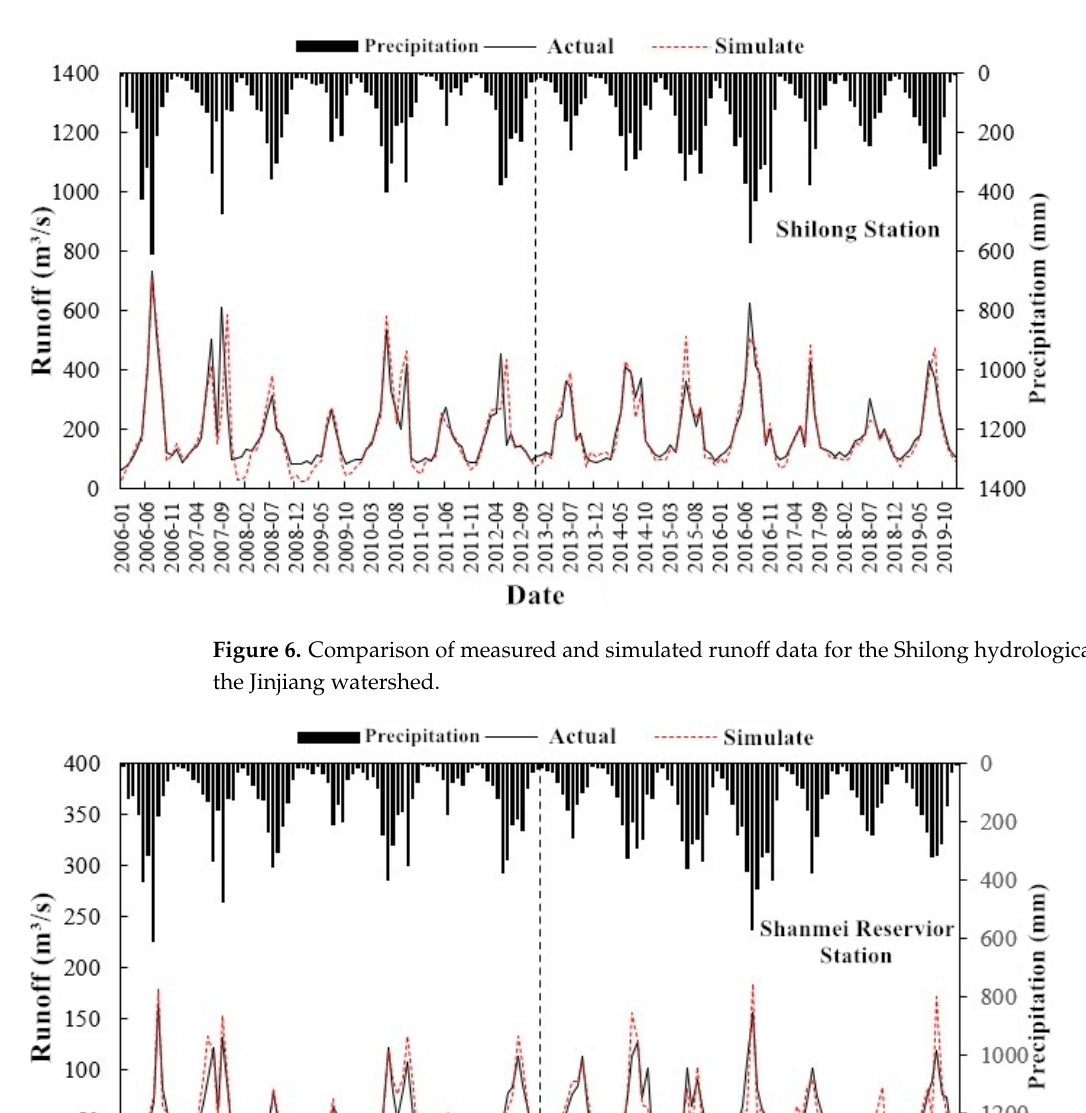
Figure 8. Comparison of measured and simulated runoff data for the Anxi hydrological station in the Jinjiang watershed. Table 2. Simulation results for the calibration and validation periods for three hydrological stations in the Jinjiang watershed. Station